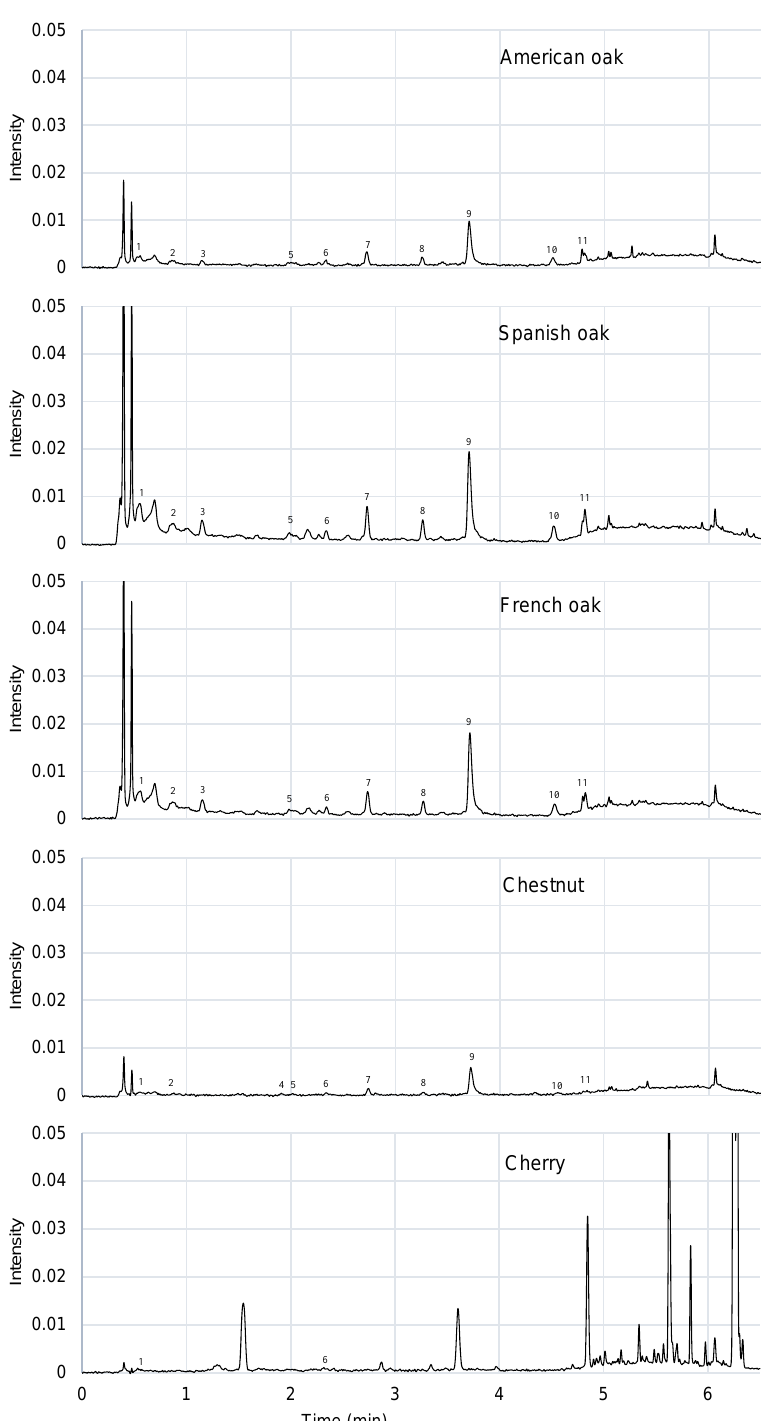
Figure 6. Ultra-High-Performance Liquid Chromatography (UHPLC) chromatogram comparison of the hydroalcoholic wood extracts at 280 nm. The key for the compounds is in Table 9.